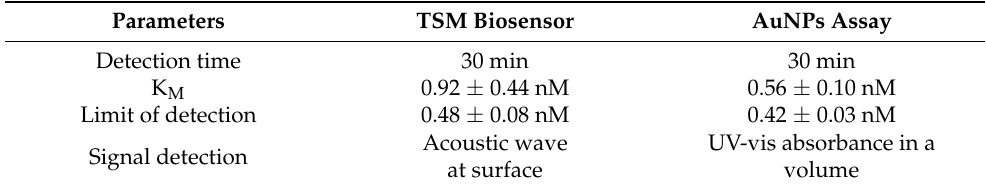
Table 2. Comparison of TSM biosensor and AuNPs platform (colorimetric biosensor) used for the detection of trypsin